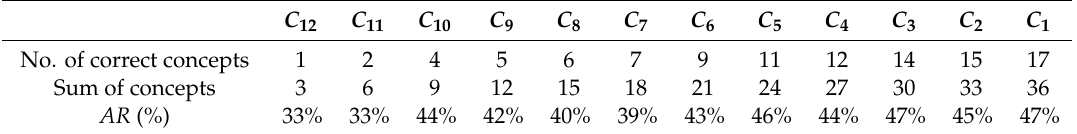
Table 4. Learning achievement results for student 3, who correctly answered Q 1 , Q 3 , Q 4 , Q 7 , Q 8 , Q 10